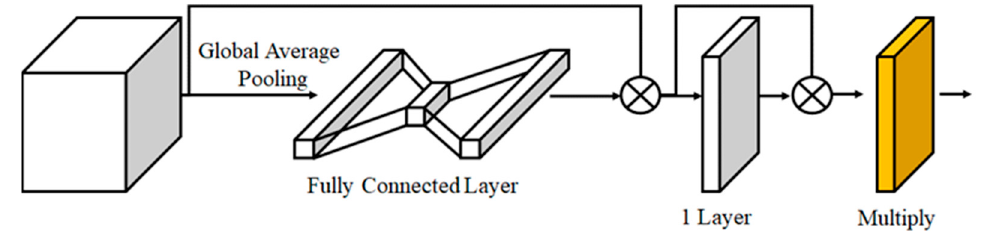
Figure 8. Channel Spatial Block.